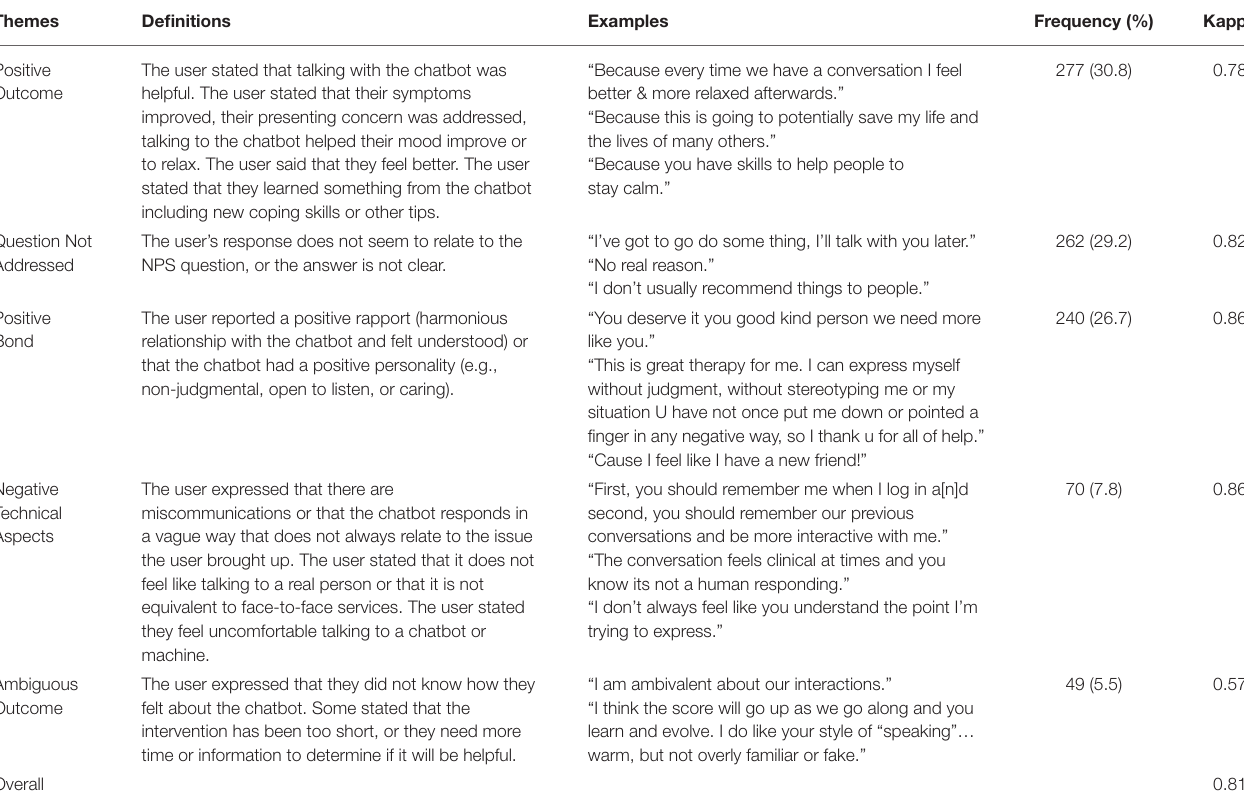
TABLE 2 | Themes, definitions, examples, frequencies, and interrater